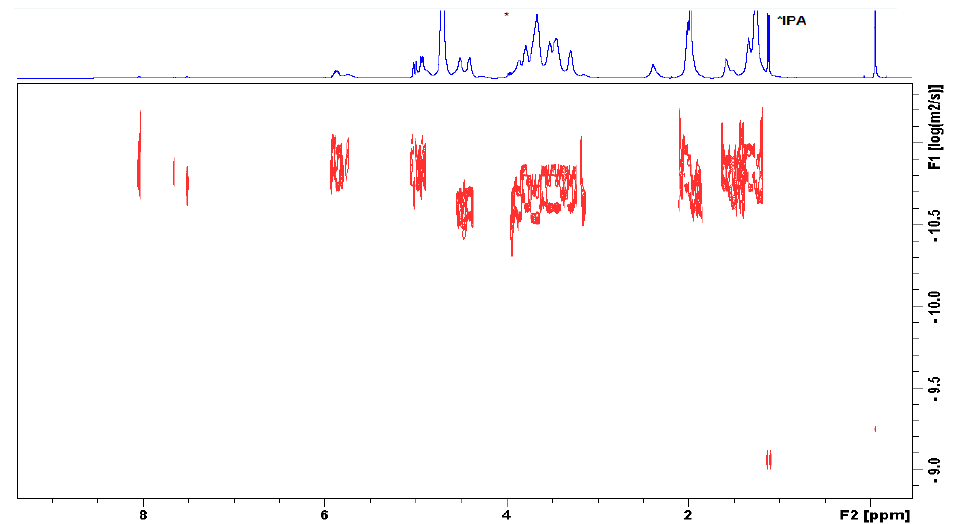
Figure 4. Diffusion-ordered spectroscopy ( DOSY) spectrum of HA-UDA determined in D 2 O (HA- UDA, 15 kDa and DS = 35.4%), containing isopropanol as impurity.